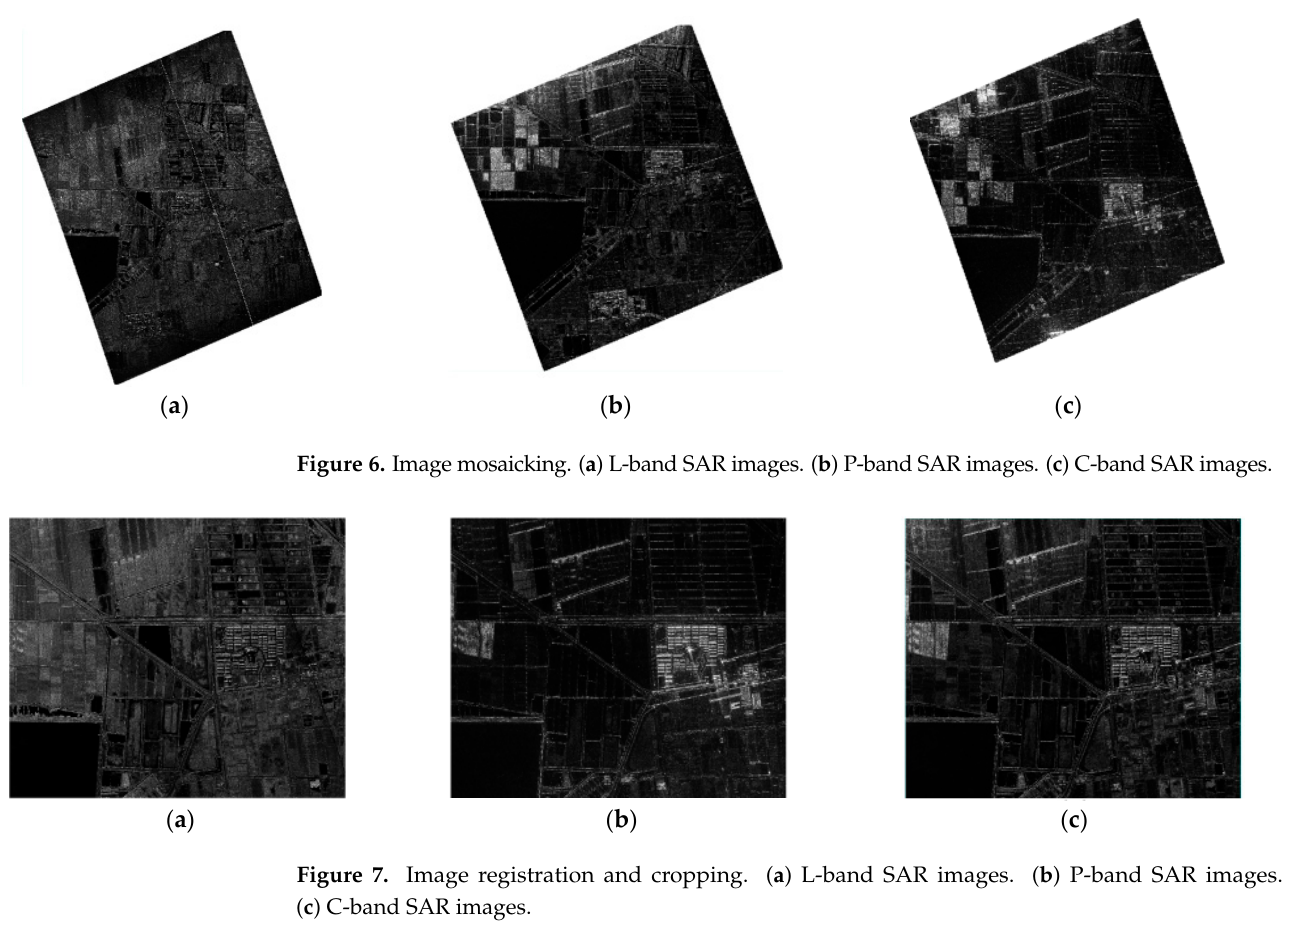
Figure 5. ( a ) Two L-band SAR images. ( b ) Two P-band SAR images. ( c ) Three C-band SAR images.